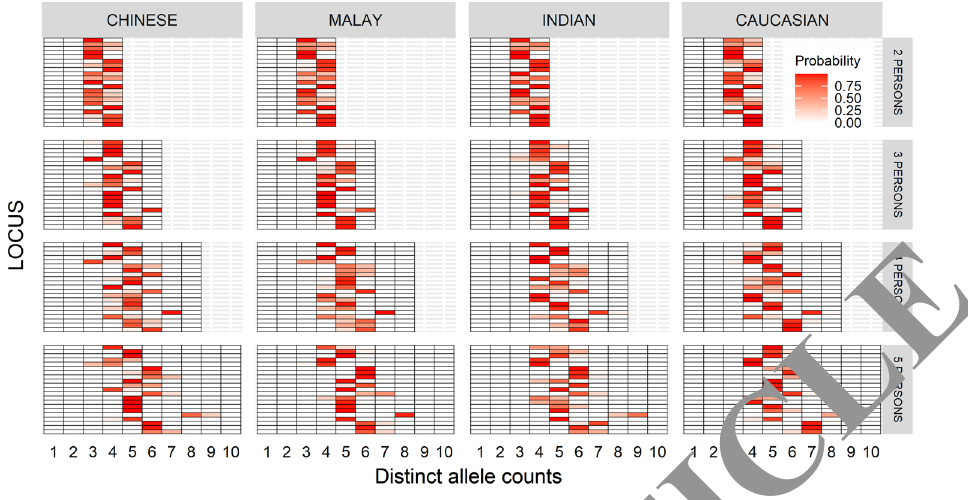
Figure 1. Heatmap of distinct allele counts generated from simulation without considering allele dropout. The probabilities of observing different numbers of distinct alleles obtained in a DNA mixture are displayed. The probabilities are categorised according to the different ethnic groups (in column) and the different NOC in the DNA mixture profiles (in rows). The 21 autosomal loci listed from top to bottom are: D3S1358, vWA, D16S539, CSF1PO, TPOX, D8S1179, D21S11, D18S51, D2S441, D19S433, TH01, FGA, D22S1045, D5S818, D13S317, D7S820, SE33, D10S1248, D1S1656, D12S391, and